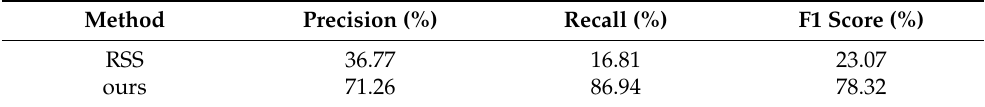
Table 2. Comparison of the results between with RSS and our method.